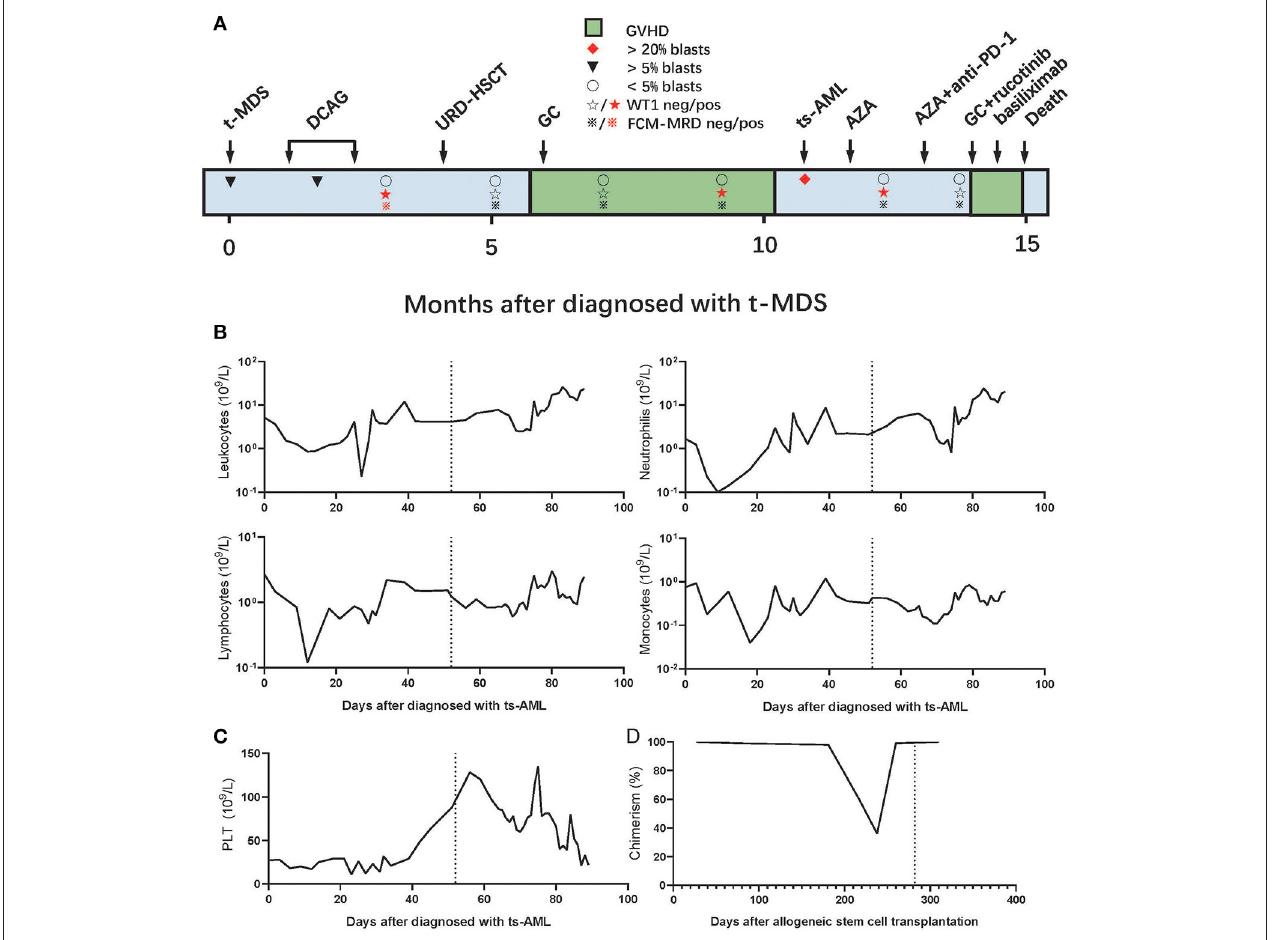
FIGURE 1 | (A) Clinical course of the patient. (B,C) Numbers of (B) leukocytes, lymphocytes, neutrophils, monocytes, and (C) platelets in the peripheral blood after the AML diagnosis. (D) Donor cell chimerism in the bone marrow (BM) following allo-HSCT. In (B–D) , the dotted vertical line indicates the timing of tislelizumab administration. GC, glucocorticoid; AZA, azacytidine; t-MDS, therapy-related myelodysplastic syndrome; ts-AML, treated secondary-acute myeloid leukemia. URD-HSCT, unrelated donor hematopoietic stem cell